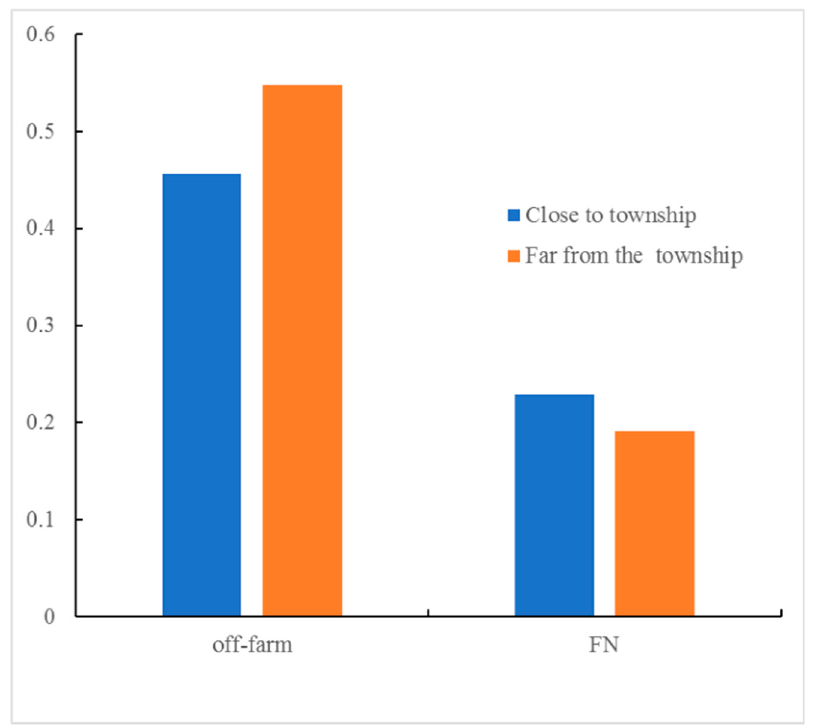
Figure 8. E ff ects of distance from a township on o ff -farm labor and forest fragmentation. O ff -farm, the mean value of proportion of households with o ff -farm labor in 2013; FN, the mean value of forest fragmentation in